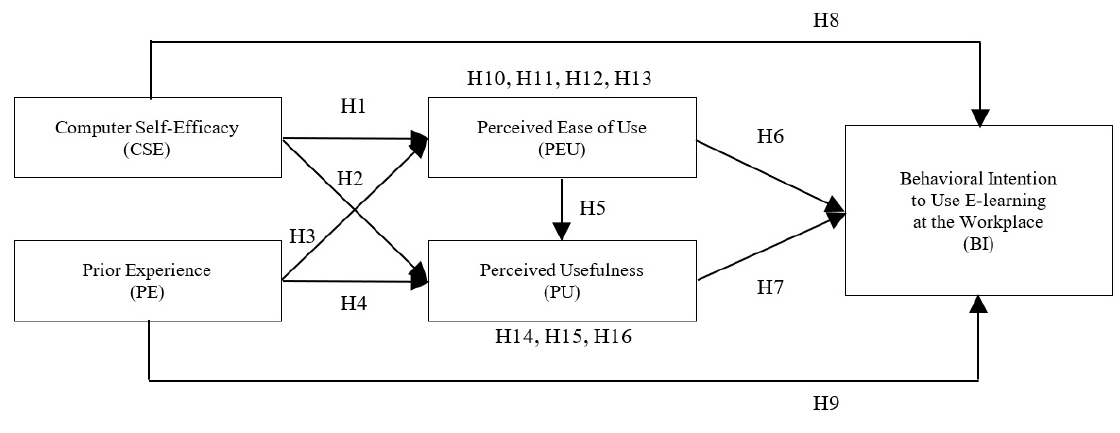
Figure 1. Research model to determine behavioural intention to use e-learning in the workplace. In addressing gaps in literature, the research model integrates SCT and TAM to evaluate behavioural intention to use e-learning in the workplace. This study attempts to address certain SCT limitations which emphasize that learning occurs within a person and do not consider external factors (Garcia Carreño,